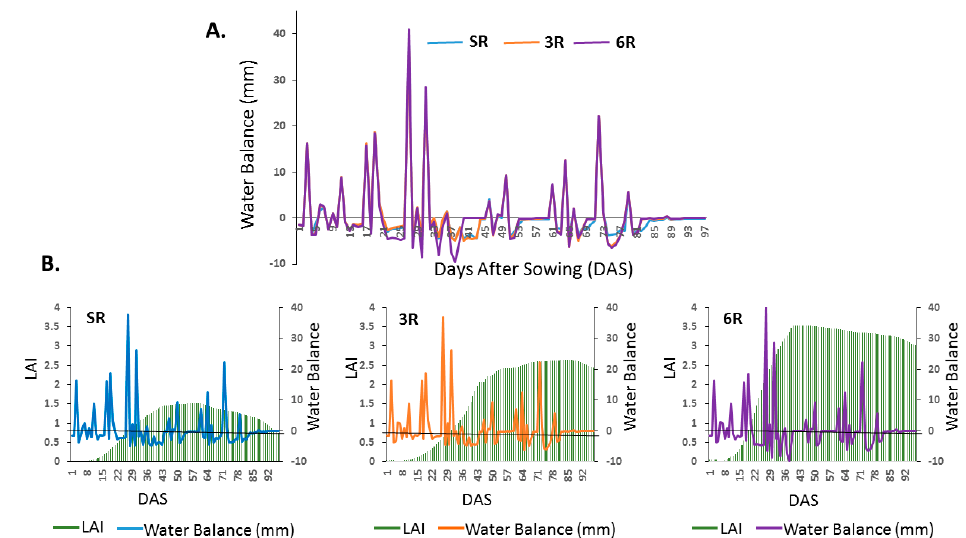
Figure 9. Water balance ( A ) and leaf area index (LAI) ( B ) for the growing season 2032 under climatic scenario RCP4.5 for rainfed common bean cultivar Azufrado 2 (growth habit I) under sowing densities of 90,000 (SR), 145,000 (3R) and 260,000 (6R) plants ha − 1 in the semi-arid temperate highland of Pabellon de Arteaga in Aguascalientes, Mexico.